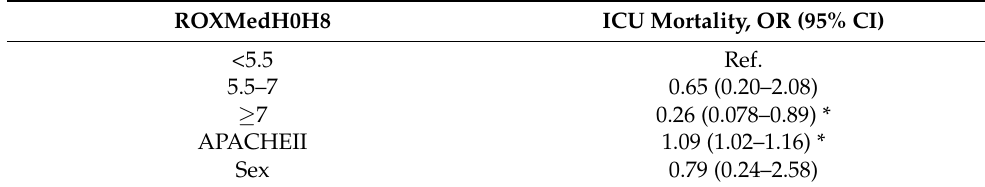
Table 4. Multivariable analysis with ROXmedH0H8, APACHE II